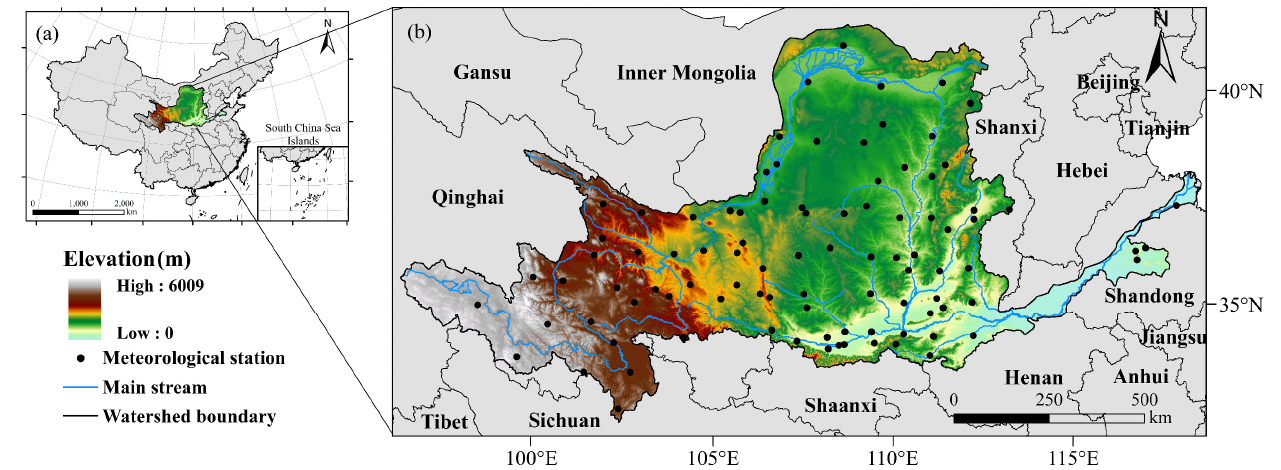
Figure 1. ( a ) Location and digital elevation model of the Yellow River Basin in China and ( b ) the distribution of 93 national meteorological stations in the Yellow River Basin.